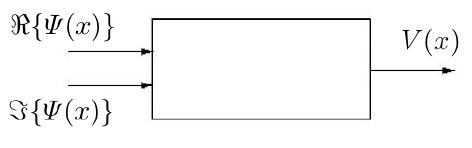
Figure 9. Identifiable system for the inverse quantum scattering problem. The two inputs are the real and imaginary parts of the scattered wave function, while the output is the scattering